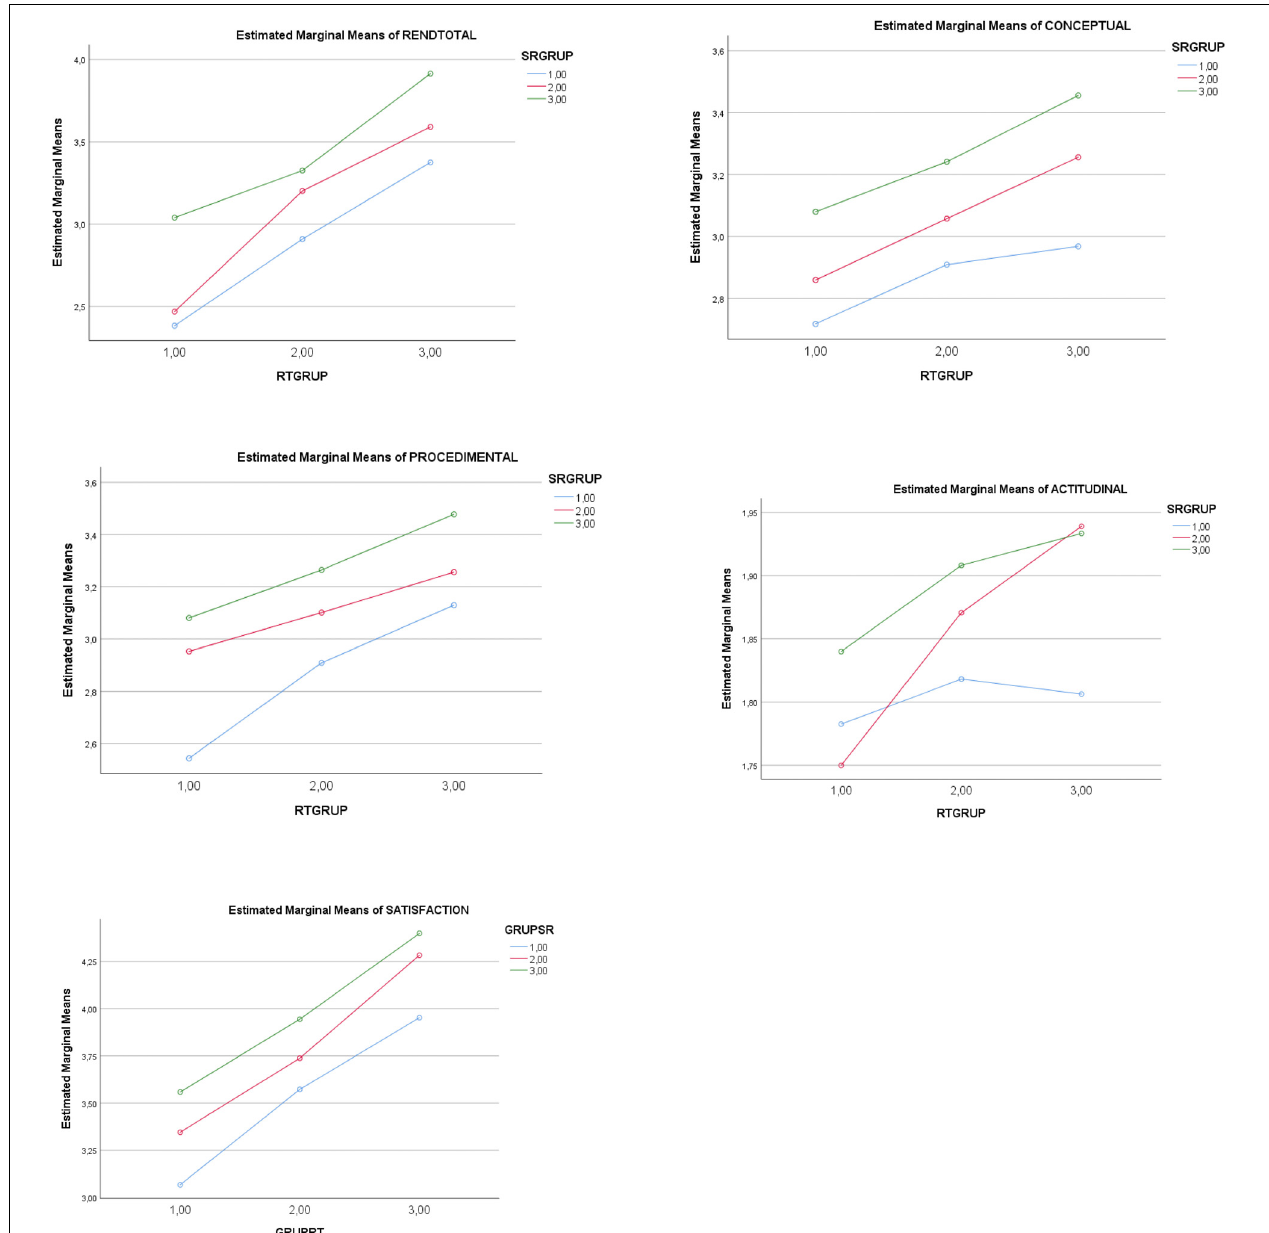
FIGURE 2 | Graphic representation of the effect of low(1)-medium(2)-high(3) levels in the IV self-regulation (GRUPSRQ) and low(1)-medium (2)-high (3) levels in the IV regulatory teaching (GRUPER) on academic achievement ( conceptual , procedural , and attitudinal ) and satisfaction with the teaching and learning